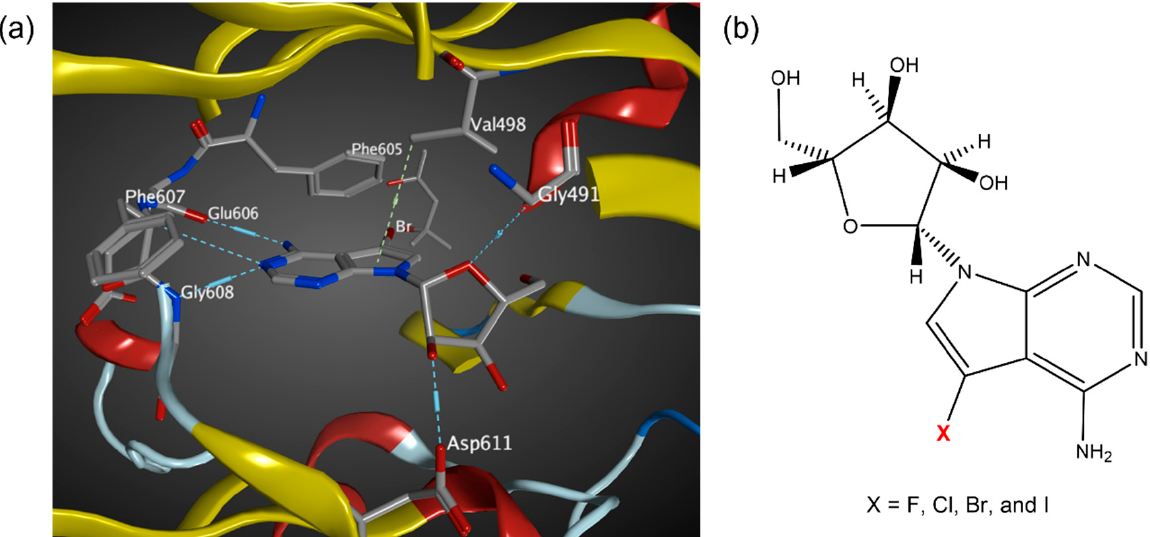
Figure 1. ( a ) Interaction site of tubercidin inhibitors with Haspin key residues (PDB 6G35). ( b ) Molecular structures of halogenated tubercidin derivatives.